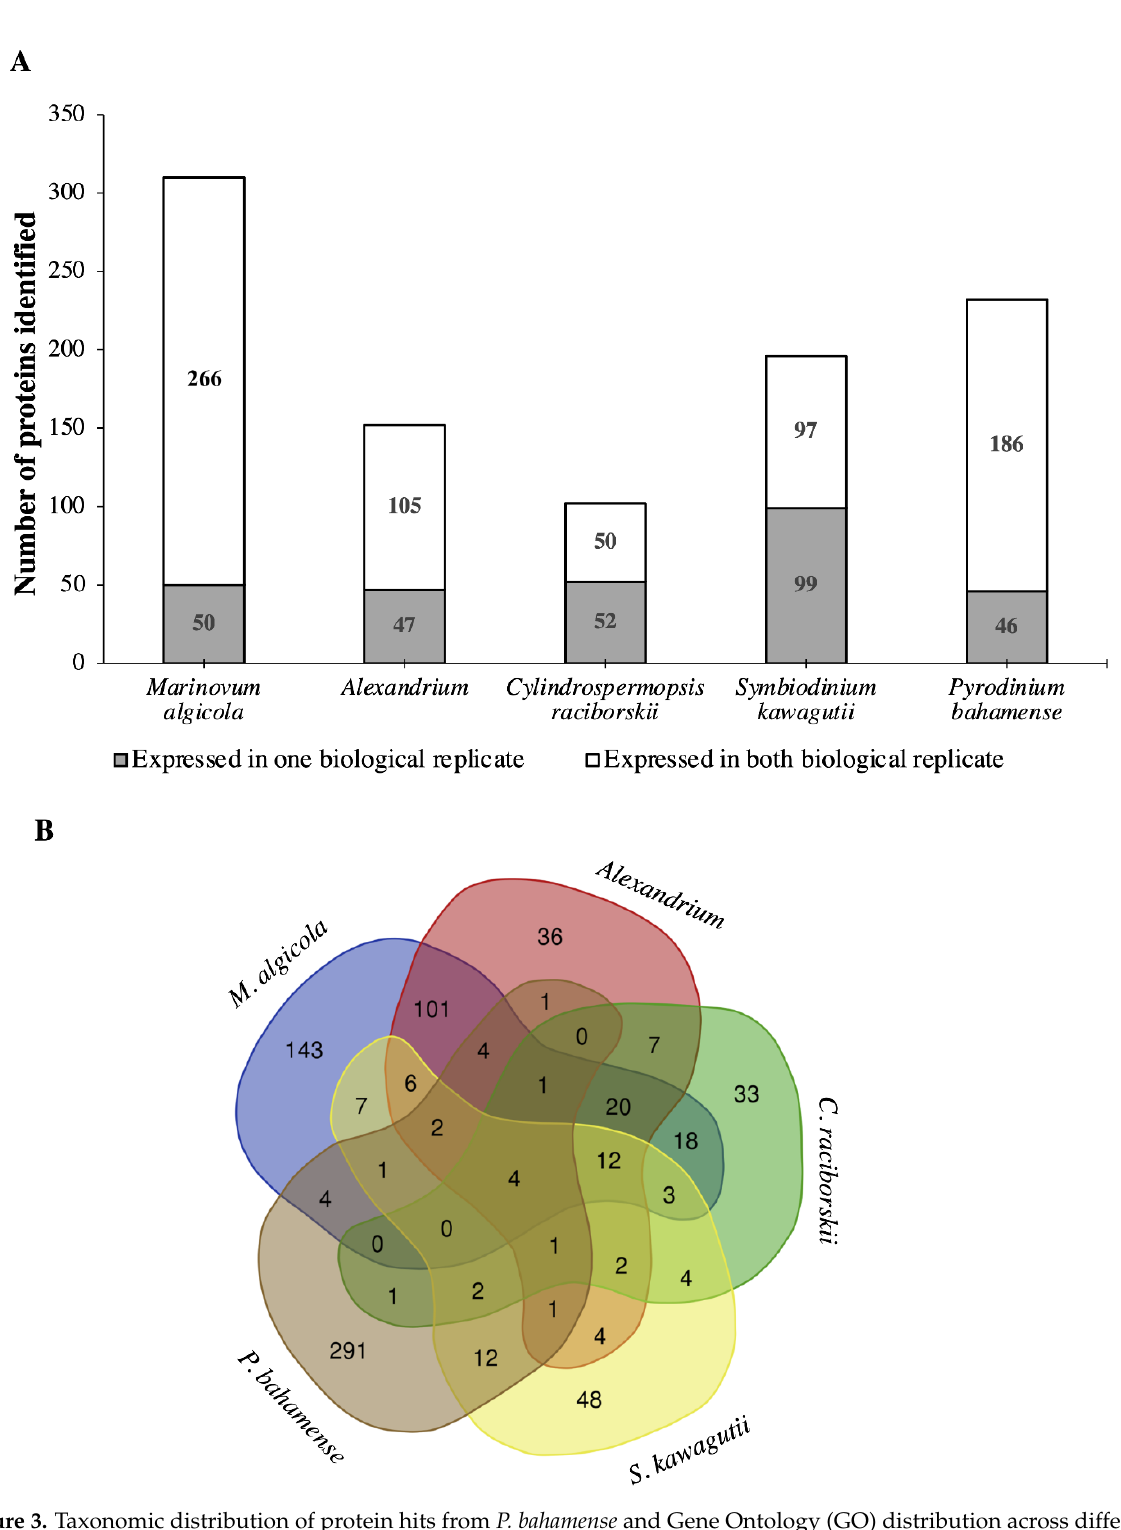
Figure 3. Taxonomic distribution of protein hits from P. bahamense and Gene Ontology (GO) distribution across different reference genomes: ( A ) Highest hits were observed using M. algicola and P. bahamense as reference. Majority of the annotated proteins were detected in the two biological replicates. Several proteins were detected in only one replicate and may indicate possible protein variation due to regulation [45,46] and/or low abundance proteins. ( B ) The highest number of non-overlapping GO identifiers were mapped onto M. algicola and P. bahamense . Proteins identified were sorted according to their gene ontology (GO) identifiers. Annotation of the GO ID produced the following unique elements or non-redundant GO identifications: Alexandrium sp. (36), C. raciborskii (33), M. algicola (143), P. bahamense (291), and S. kawagutii (48).